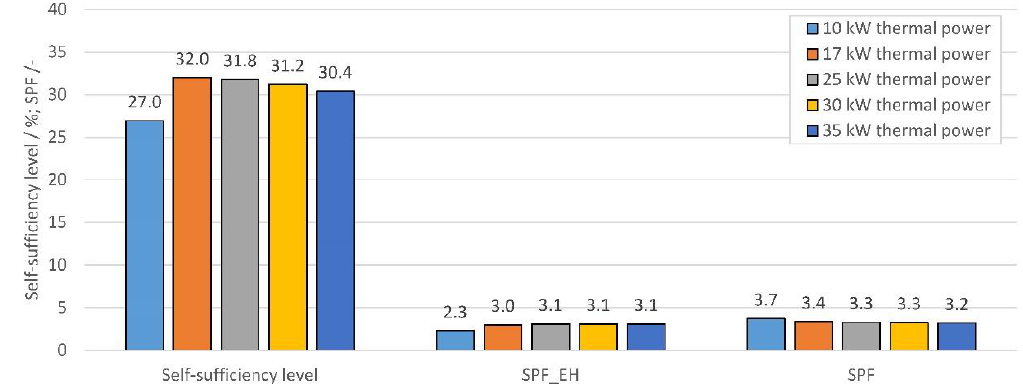
Figure 5. Self-sufficiency level and seasonal performance factors of MFH category 1 reference building for year 2020 with variation of brine–water heat pump (BWHP) size.